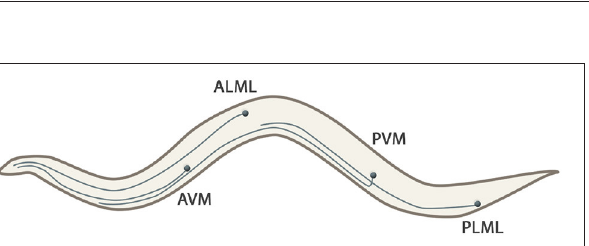
represent the number of connections formed by the neurons to the respective